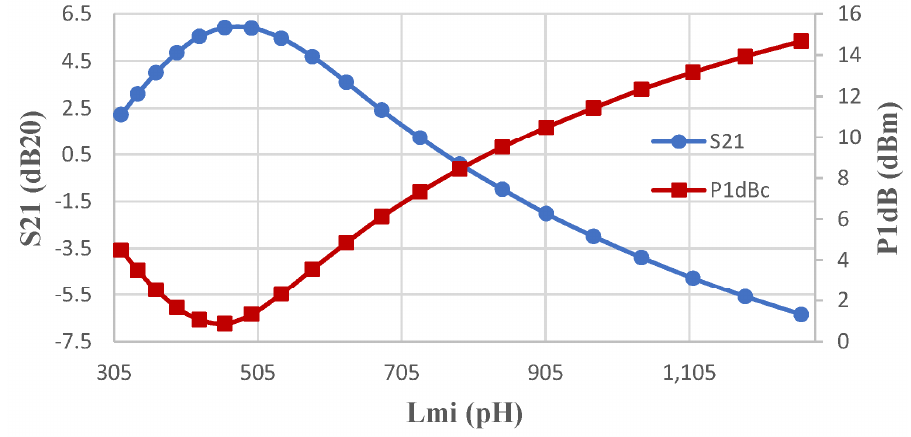
Figure 6. Gain and Input P1dB versus the input inductance of the input matching network.